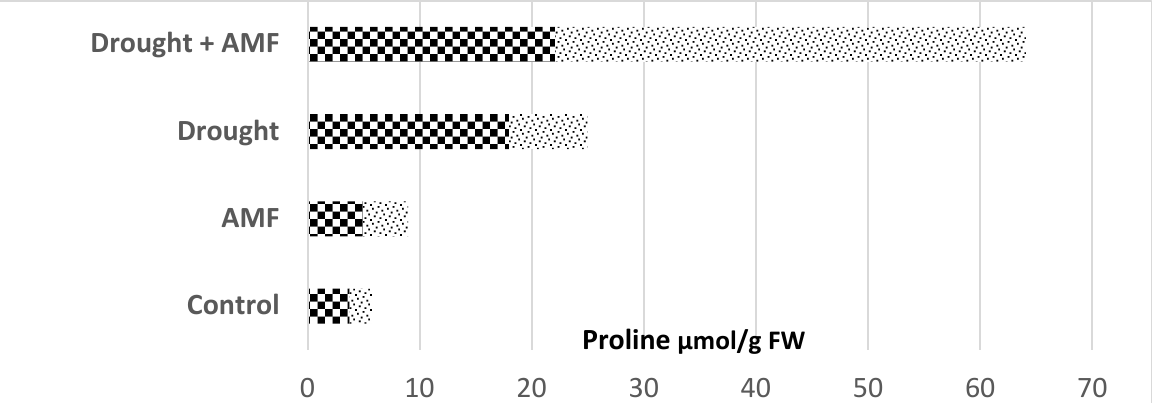
Figure 5. Symbiotic mycorrhizal fungi alone and abiotic stress alone, or their combination, altered accumulation of proline in cucumber